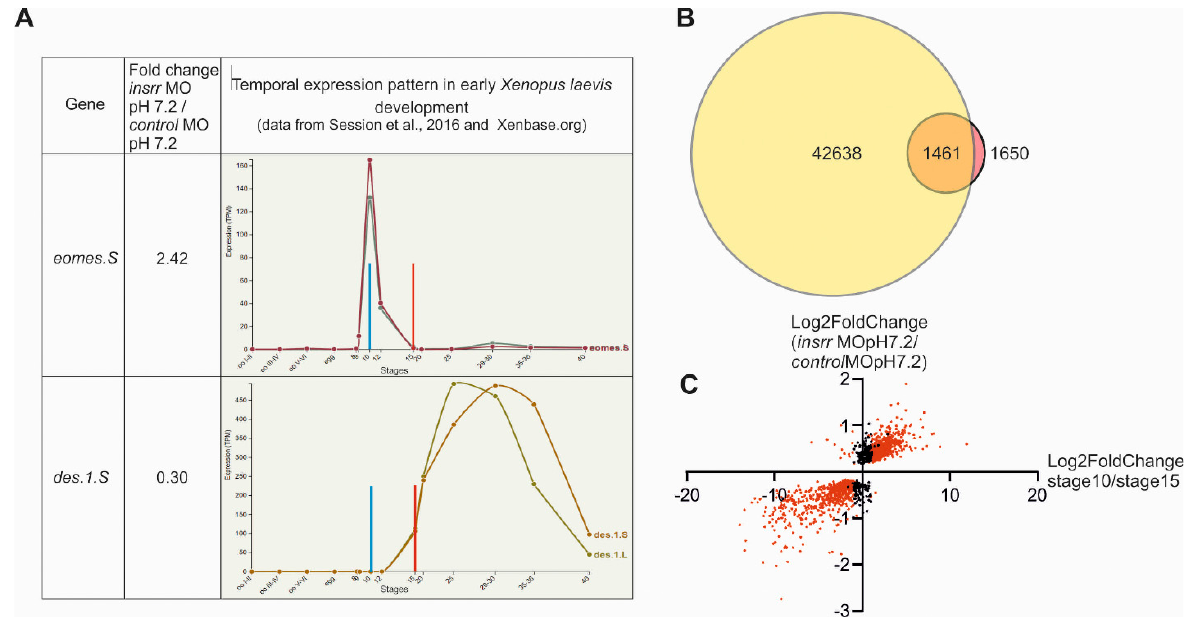
Figure 3. ( A ). Example of the temporal expression profiles of eomes.S and des.1.S genes. Data from [19] and Xenbase.org. ( B ). The intersection of expressed genes from previously published Xenopus laevis stage gene expression analysis at 10 and 15 stages and DEGs between transcriptomes of the control and insrr MO1-injected embryos at pH 7.2. ( C ). Graphical plot log2 (Fold change insrr MO 7.2/control MO 7.2) vs. plotted log2 (FoldChange stage10/stage15) for each 1465 DEGs. Red color indicated only DEGs between stage 10 and stage 15. Table 1. Top 15 downregulated (red) and 15 upregulated genes (green) after MO1 injection into embryos at pH 7.2.